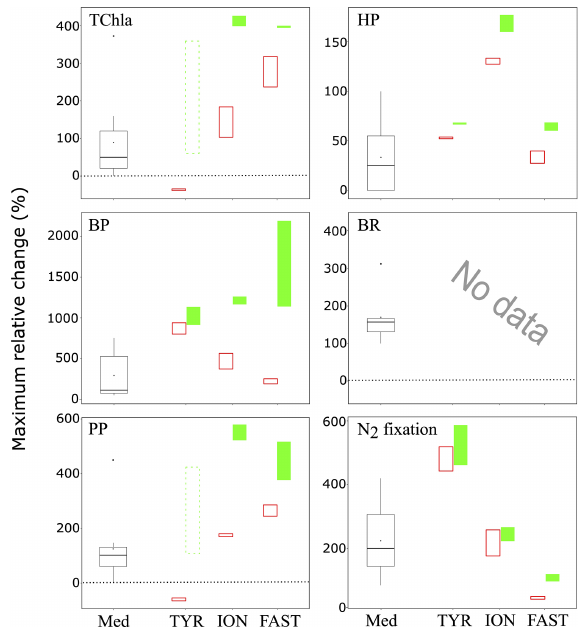
Figure 10. Maximum relative change (%) of main biological stocks (TCHl a : total chlorophyll a , HP: heterotrophic prokaryotes) and processes (BP: bacterial production; PP: 14 C-based primary pro- duction; see Gazeau et al., 2021; BR: bacterial respiration (no data from this study); and N 2 fixation, Ridame et al., 2021) obtained during the present study at the three stations (TYR, ION and FAST) under ambient conditions of pH and temperature (open red squares) and future conditions (full green squares). Vertical extension of each squares are delimited by the range of responses observed among the duplicates for each treatment. The dotted green squares for station TYR highlight the large variability observed between duplicates for some parameters and processes that prevented drawing solid con- clusions. Box plots (Med) represent the distribution of responses observed from studies conducted in the Mediterranean Sea, as com- piled by Guieu and Ridame